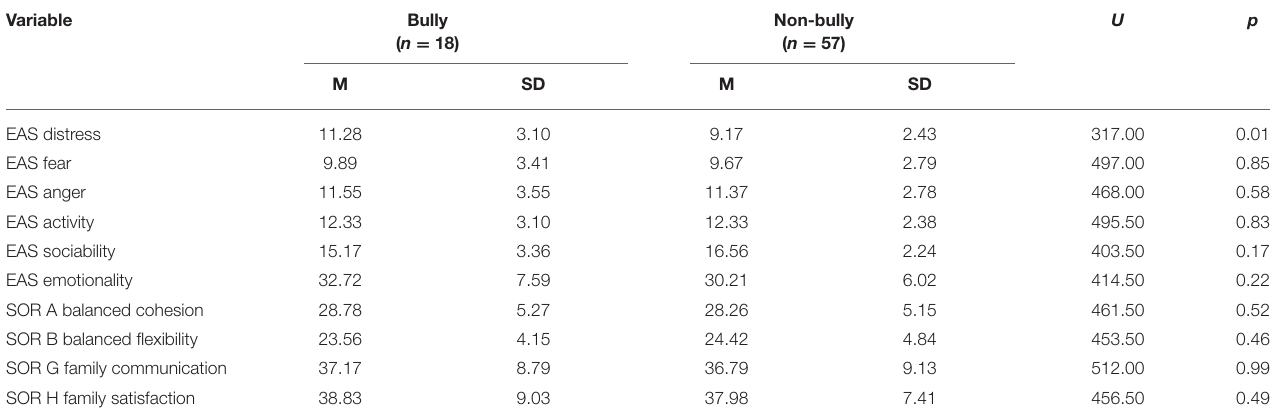
TABLE 2 | Descriptive statistics for groups of bullies ( n = 18) and non-bullies group ( n = 57). Variable Bully